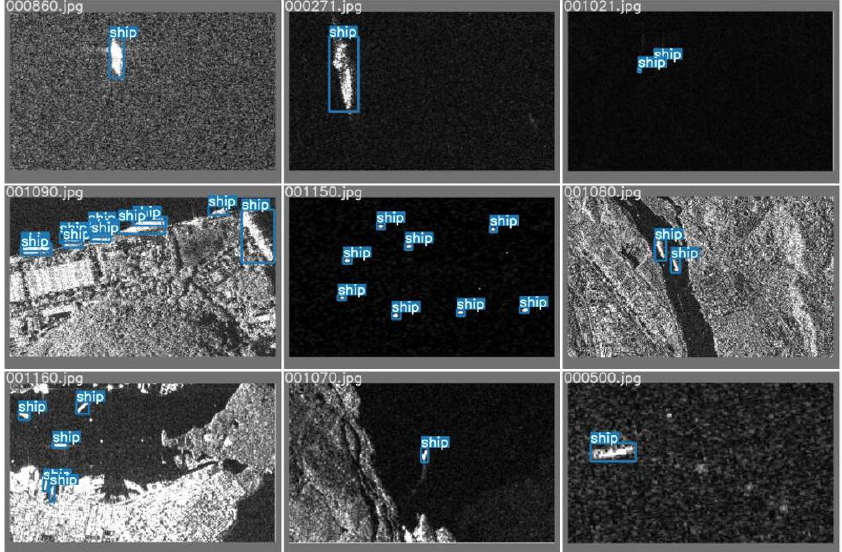
Figure 10. SAR images and labels in the SSDD